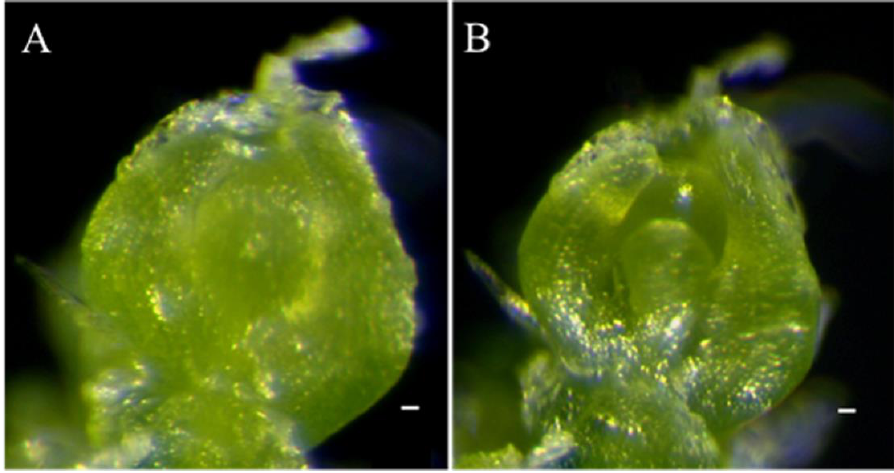
Figure 7. The SAM of WT and odd1 . ( A ) WT. ( B ) odd1. Scale bars represent 10 µ m.